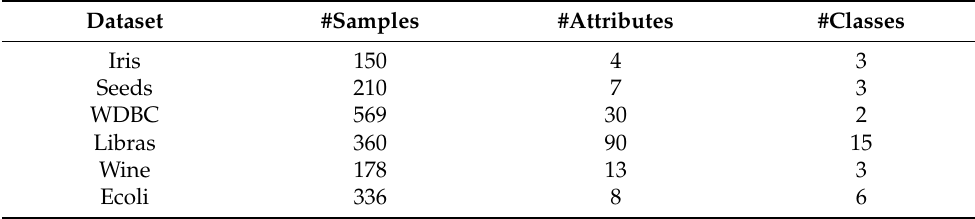
Table 2. Real-world